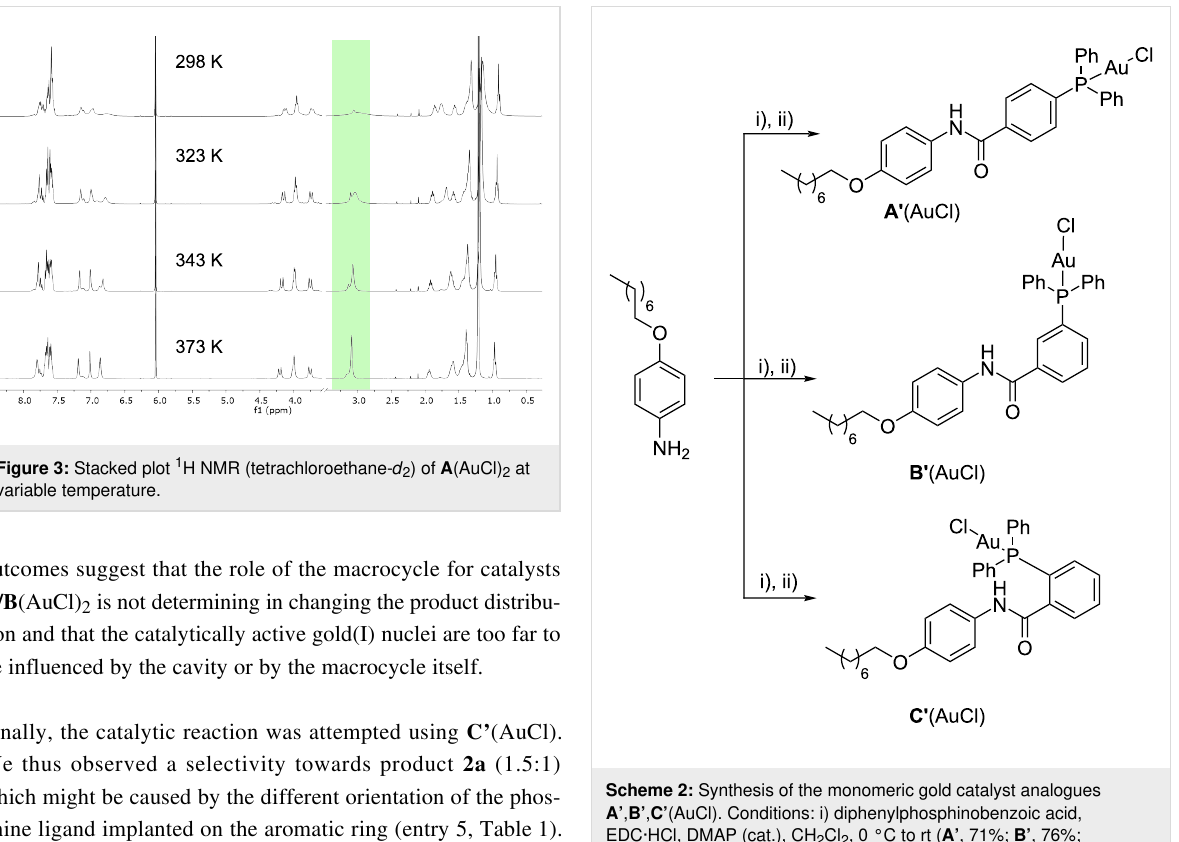
outcomes suggest that the role of the macrocycle for catalysts A/B (AuCl) 2 is not determining in changing the product distribu- tion and that the catalytically active gold(I) nuclei are too far to be influenced by the cavity or by the macrocycle itself.